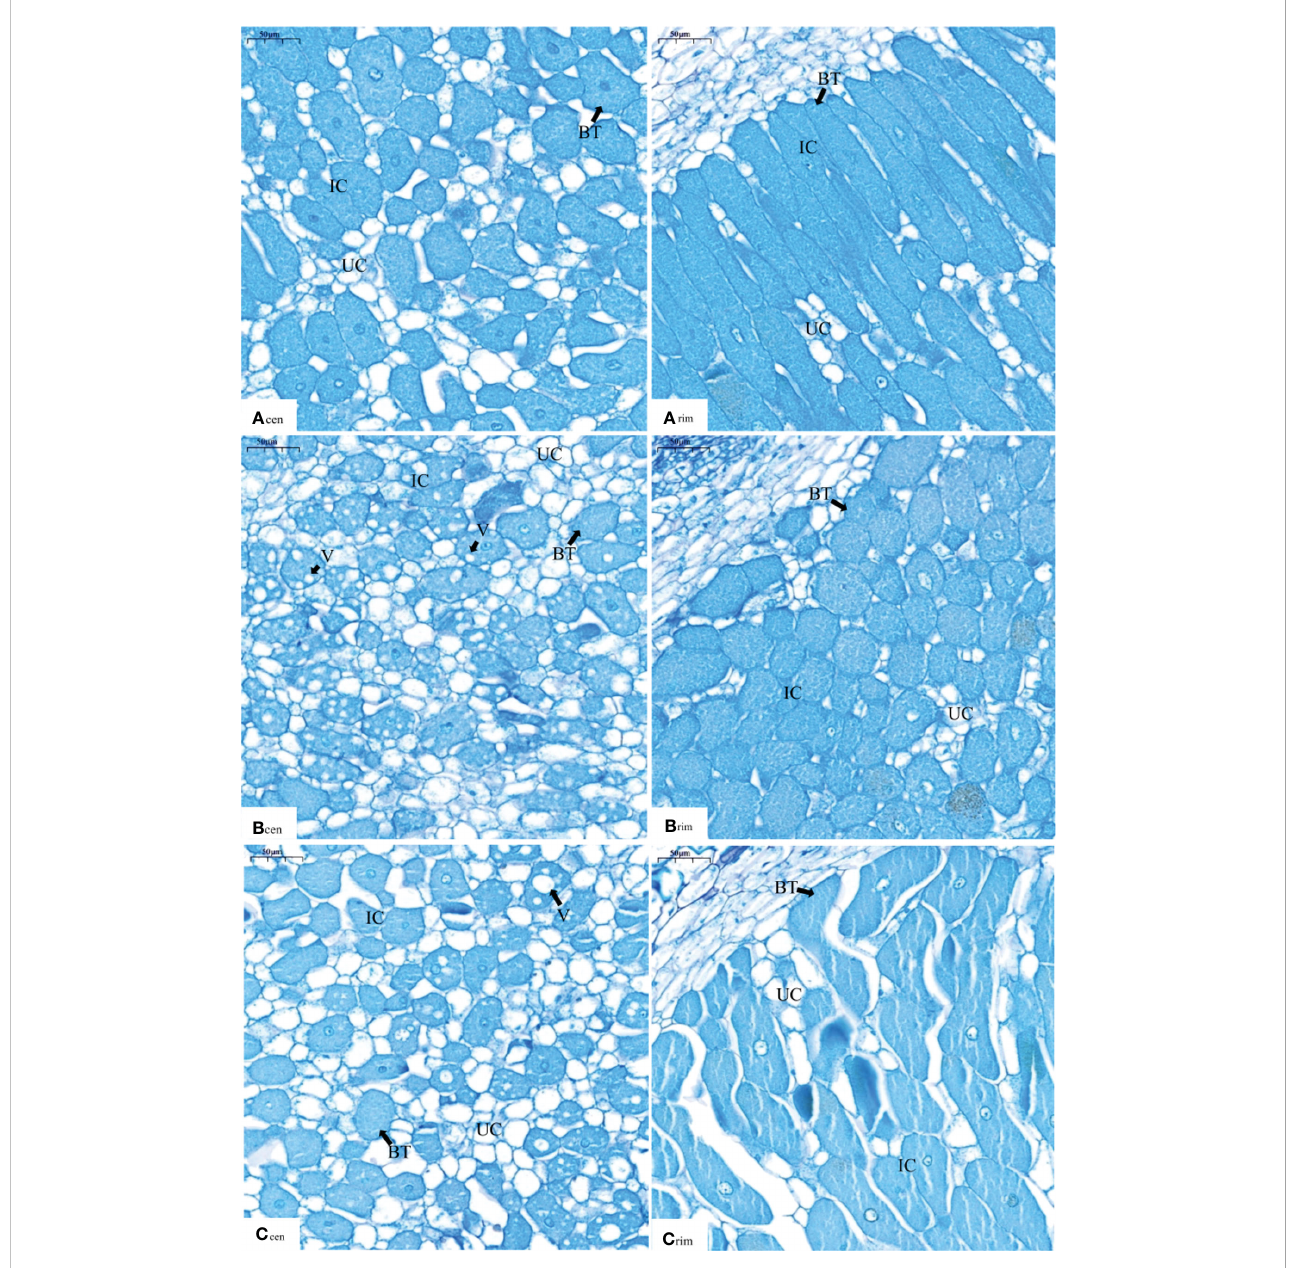
FIGURE 2 Light micrographs of nodules of dual-root soybean plants (×200). A cen , B cen and C cen are light micrographs of the central part of the nodules under the N 0 , N 100 , and N 200 treatments, respectively. A rim , B rim , and C rim are light micrographs in the edge part of nodules close to the roots under the N 0 , N 100 , and N 200 treatments, respectively. IC represents infected cells, UC represents uninfected cells, BT represents bacteroids, and V represents